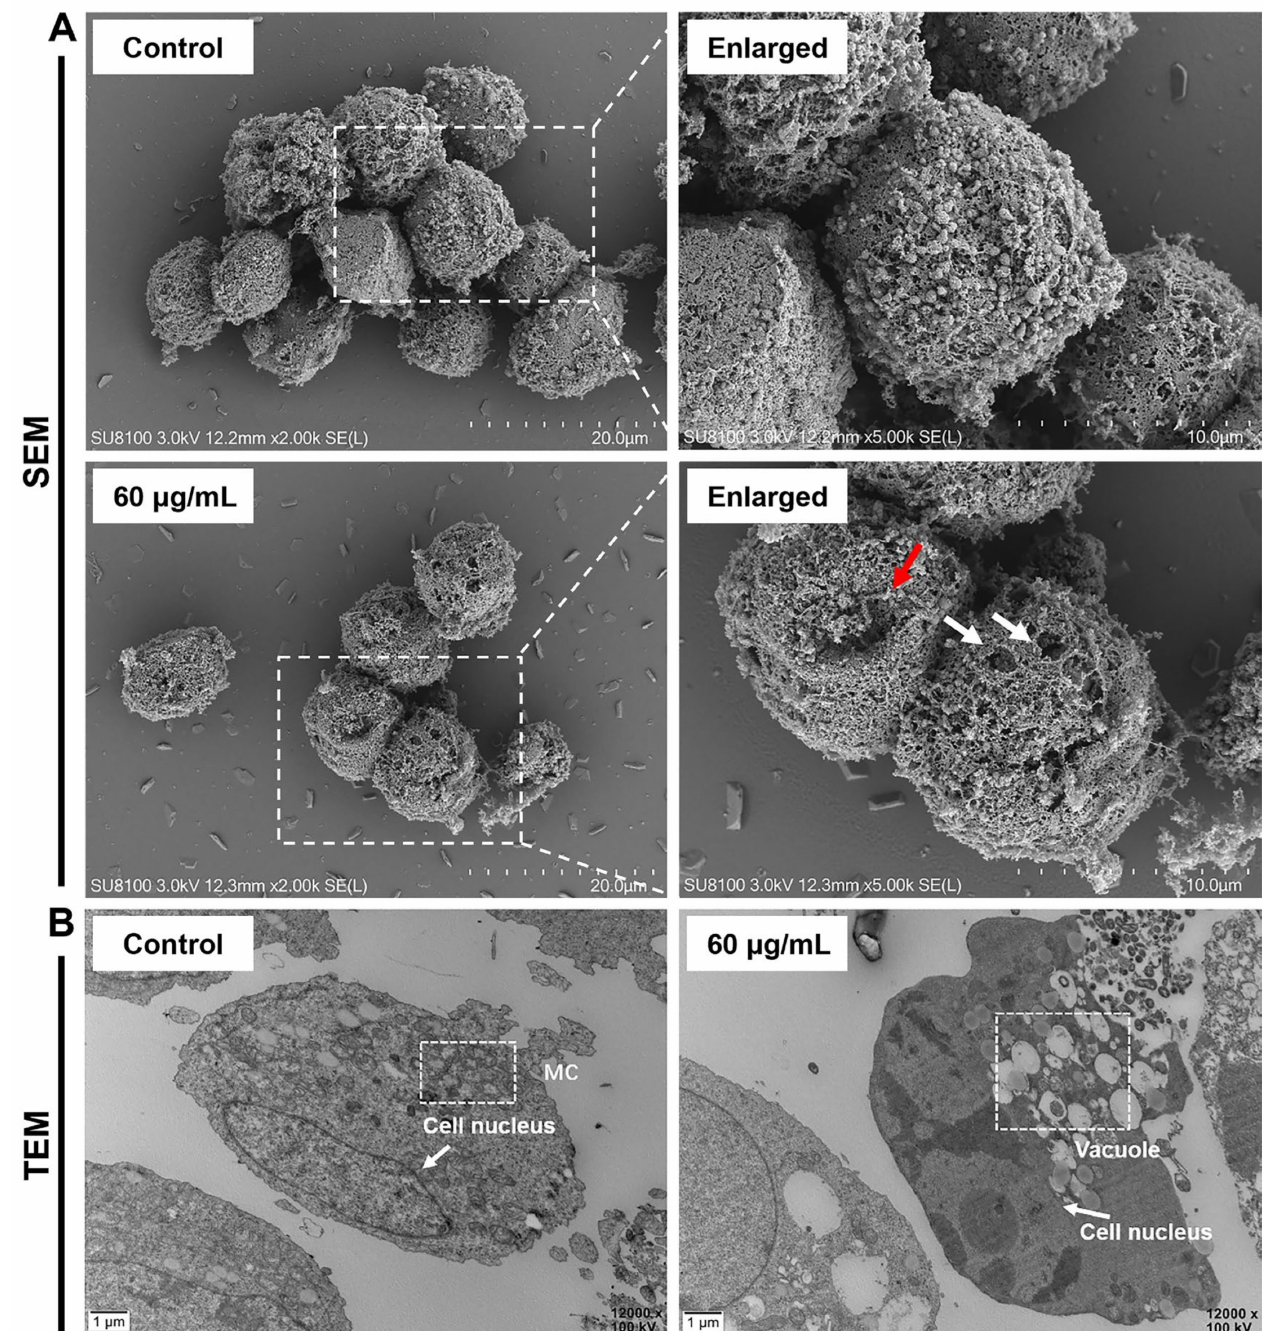
Figure 3. Effect of AMP-17 on the morphology and structure of K562 cells. ( A ) Scanning electron microscopy (SEM) images of K562 cells untreated or treated with 60 µ g/mL AMP-17 for 24 h. Images were captured using a 2000 × power field. Scale bar, 20 µ m. Enlarged images were captured using a 5000 × power field. Scale bar, 10 µ m. ( B ) Transmission electron microscopy (TEM) images of K562 cells untreated or treated with 60 µ g/mL AMP-17 for 24 h. Images were captured using a 12,000 × power field. Scale bar, 1.0 µ